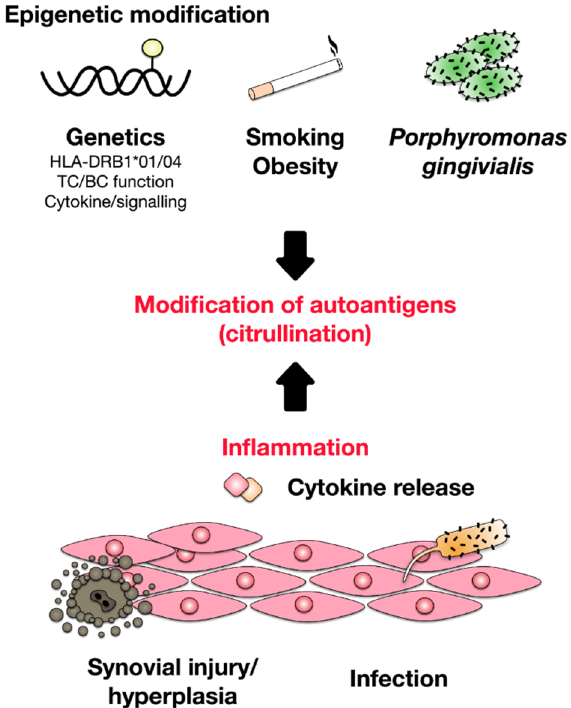
Figure 1. Factors contributing to rheumatoid arthritis (RA) development. Both